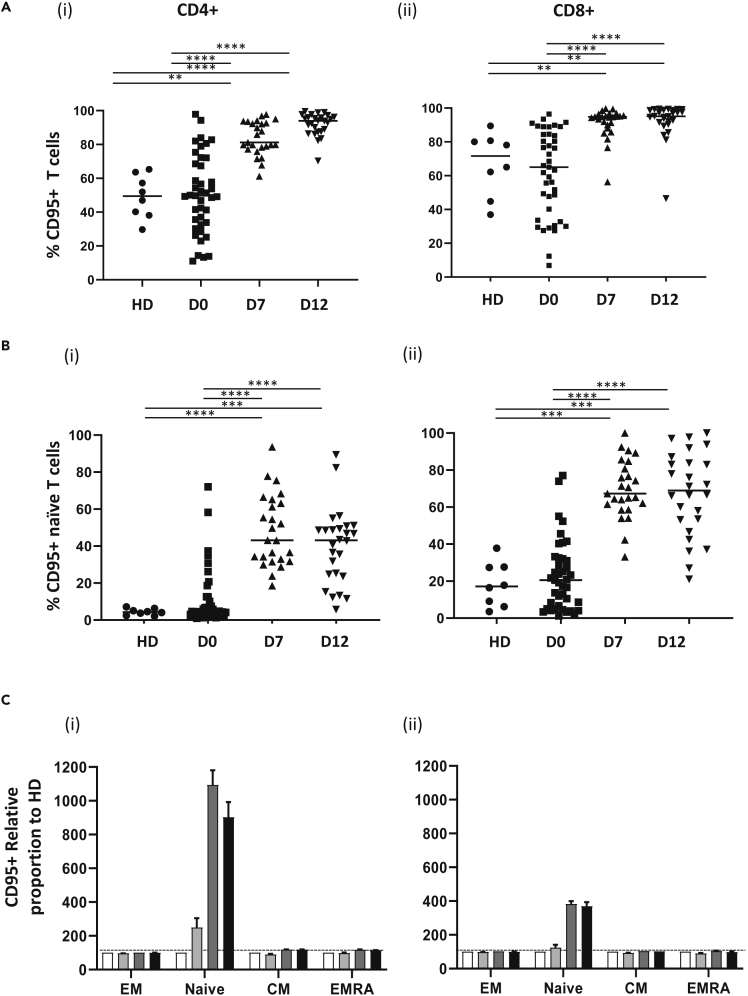
Fas expression is markedly upregulated on naive T cells during lymphopenia-induced proliferation(A) Fas (CD95) expression on CD4+ (i) and CD8+ (ii) T cells in healthy donors (HD, n = 8) and in patients at day 0 (D0, n = 41), Day 7 (D7, n = 25) and day 12 (D12, n = 26) post-transplant.(B) Proportion of naive CD4+ (i) and naive CD8+ (ii) T cells expressing CD95 in healthy donors (HD, n = 8) and in patients at D0 (n = 41), D7 (n = 25) and D12 (n = 26) post-transplant.(C) Mean proportion of CD4+ and CD8+ T cell subsets expressing CD95 in patient samples relative to healthy donors (where HD = 100% represented as dotted line) in CD4+ (i) and CD8+ (ii) T cells (HD; white bars, D0; light gray bars, WK1; dark gray bars, WK2; black bars). Error bars depict standard error mean (SEM). Kruskal-Wallis with Dunn's multiple comparison test was performed, ∗∗p < 0.01, ∗∗∗p < 0.001, ∗∗∗∗p < 0.0001.